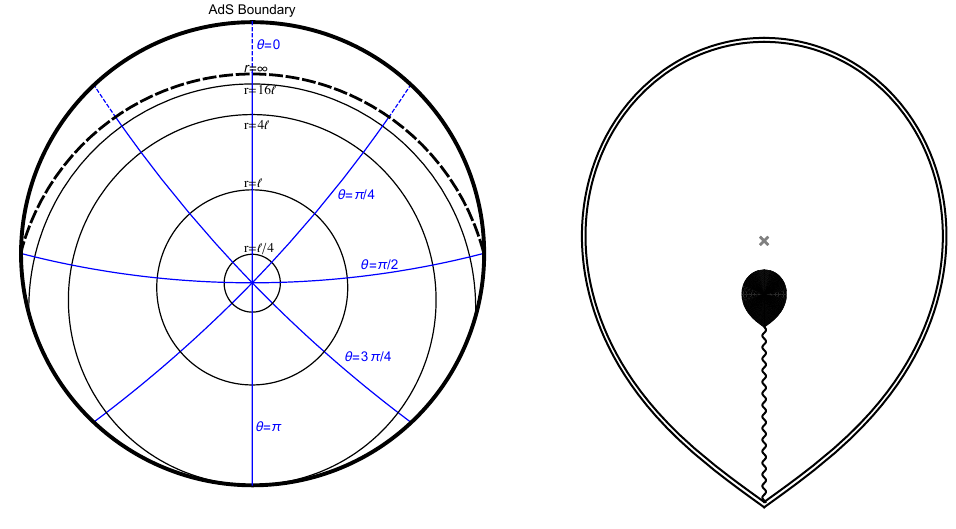
Figure 1 . Left : the slowly-accelerating Rindler spacetime shown here with A‘ = 1 = 4, and ‘ = 1 for simplicity. The spatial sections of AdS have been compacti(cid:12)ed to a Poincar(cid:19)e disc, with the constant r Rindler coordinate indicated in black and constant (cid:18) in blue. The origin of the Rindler coordinates is clearly visible as being displaced from the centre of the disc, with the limit of the r (cid:0) coordinate being the thick dashed black line. Right : the black hole distorts the Poincar(cid:19)e disc with a conical de(cid:12)cit, and is displaced from the origin of AdS. The spacetime is again static, and a cross section is